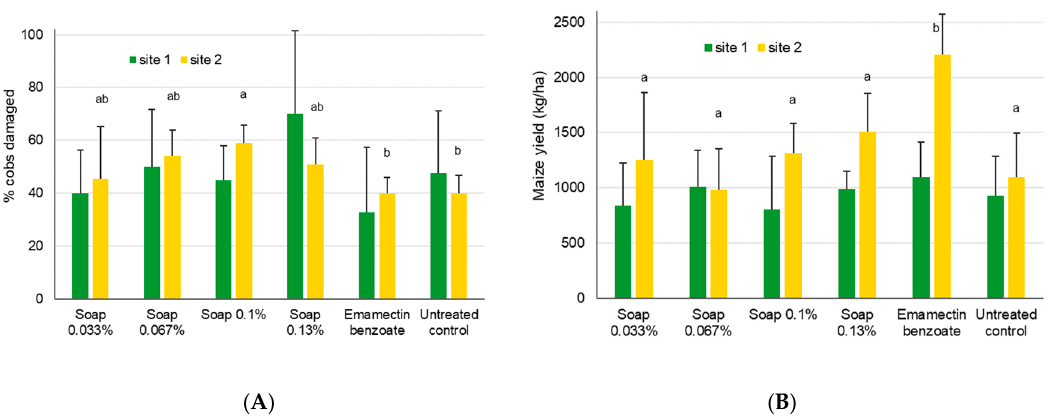
Figure 12. Mean maize cob damage induced by FAW + SD ( A ) and mean maize yields ( B ) after treatment with alata samina, a local soap, for site 1 near Wa, Upper West, Ghana, and site 2 near Accra, Ghana. Bars sharing the same letters are not significantly different from each other, while missing letters indicate that no significant differences were found.